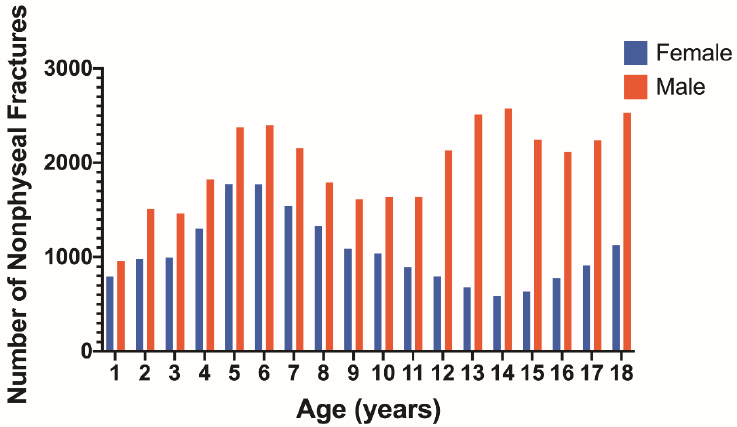
Figure 3. Number of nonphyseal fractures at each age for females (blue) and males (red). Table 1. Nonphyseal fractures for males according to age and long bone. N = 35,715.